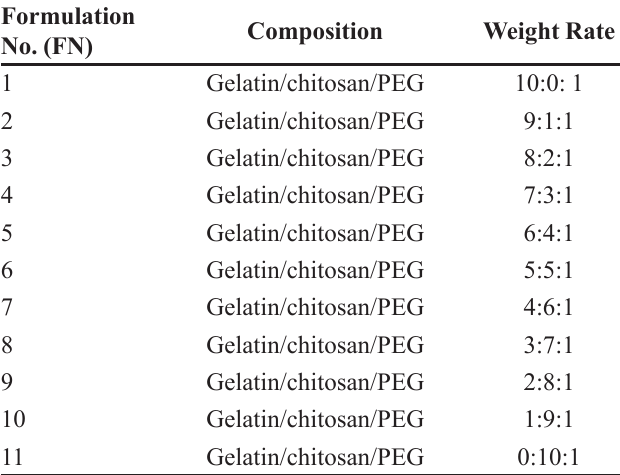
TABLE I - Formulation design of film Formulation No.